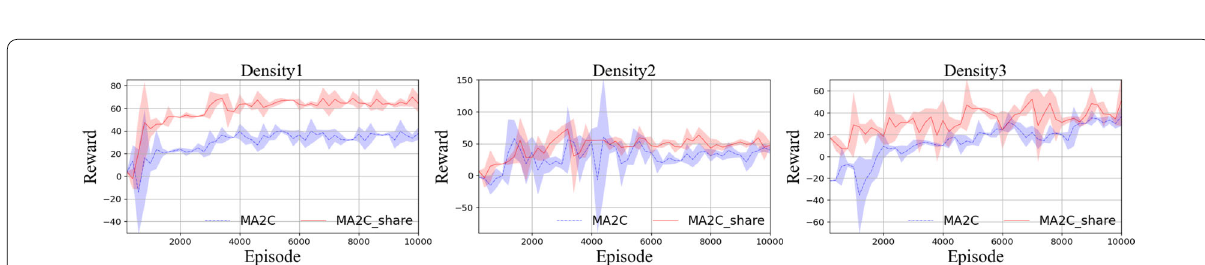
Figure 3 Performance comparisons between local and global reward designs. The shaded region denotes the standard deviation over 2 random seeds